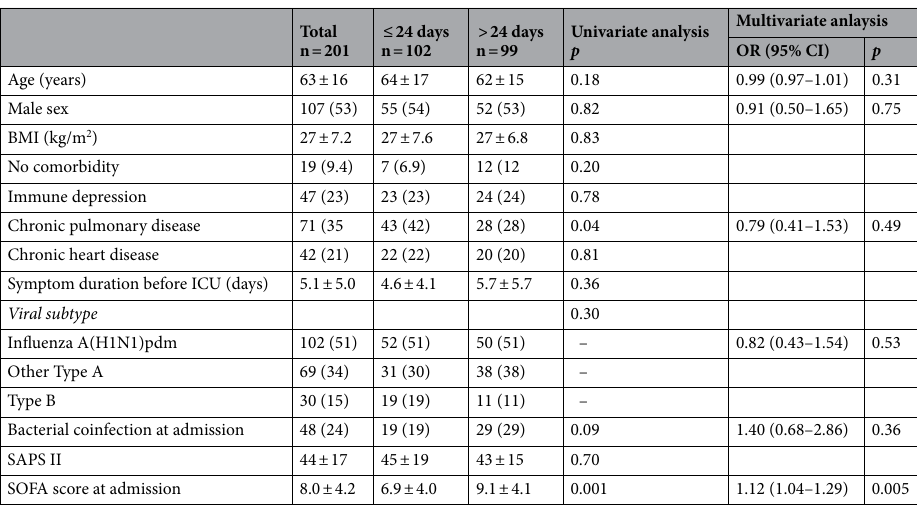
Table 4. Patients’ characteristics according to in-hospital length of stay. Data are number (%) or mean ± standard deviation, as appropriate. BMI: Body Mass Index; ICU: Intensive Care Unit; SAPS II: Simplified Acute Physiology Score II; SOFA: Sepsis-Related Organ Failure